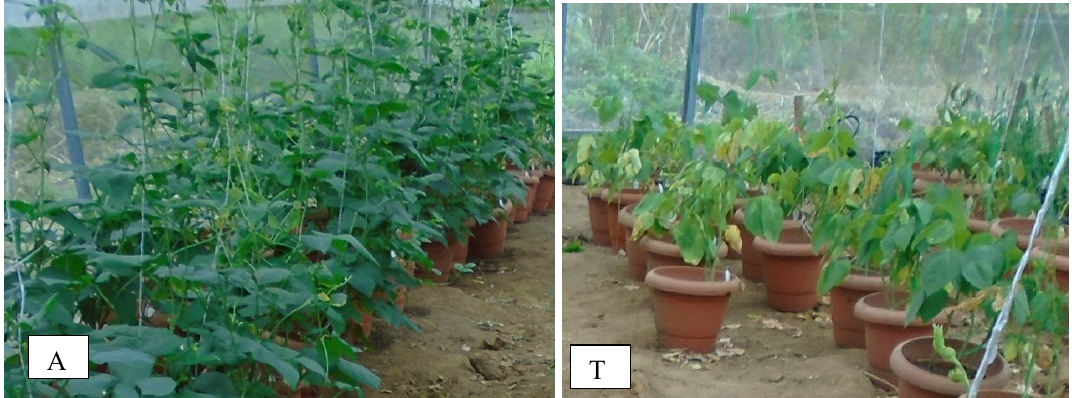
Fig. 4. Cowpea plants growing in the screen house under control (A) and drought-stressed (T) conditions. The stressed plants showing signs of wilting with yellowish leaves at week five after